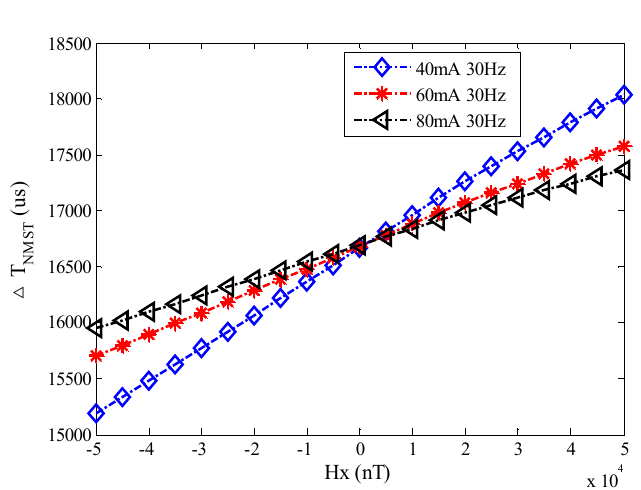
Figure 10. The curve between H x and Δ T NMST with different excitation currents.